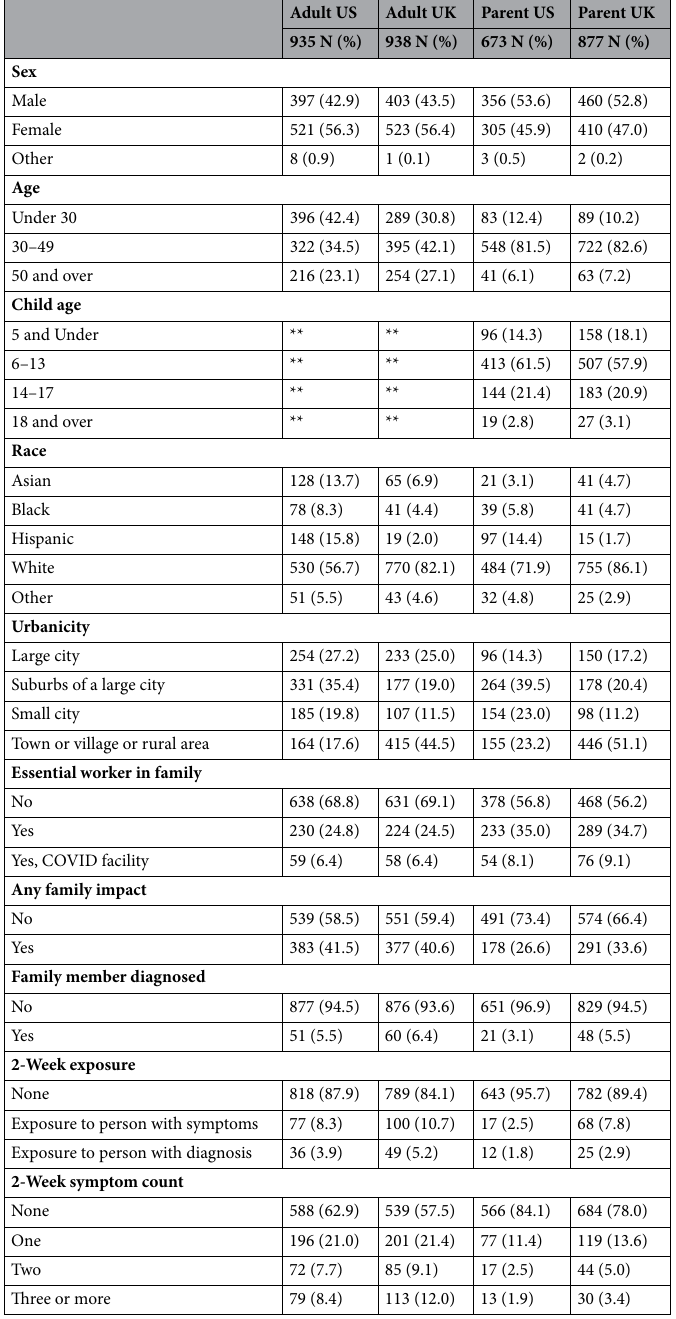
Table 1. Frequencies and percentages of key demographic variables and COVID-related experiences by